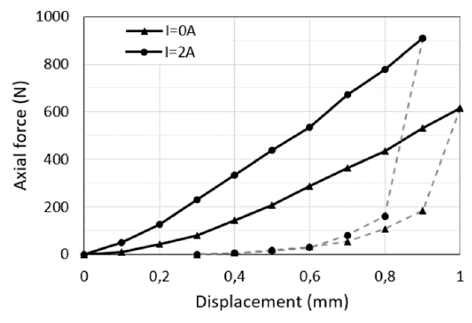
Figure 8. Force–displacement diagrams.